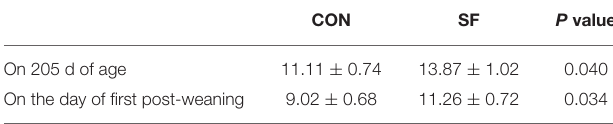
TABLE 3 | Effects of soluble fiber (SF) supplementation during the replacement TABLE 2 | Number and reason of removal sows at different parities a,b,c . phase on plasma concentration of anti-mullerian hormone (AMH) (ng/ml) a . CON SF P - value